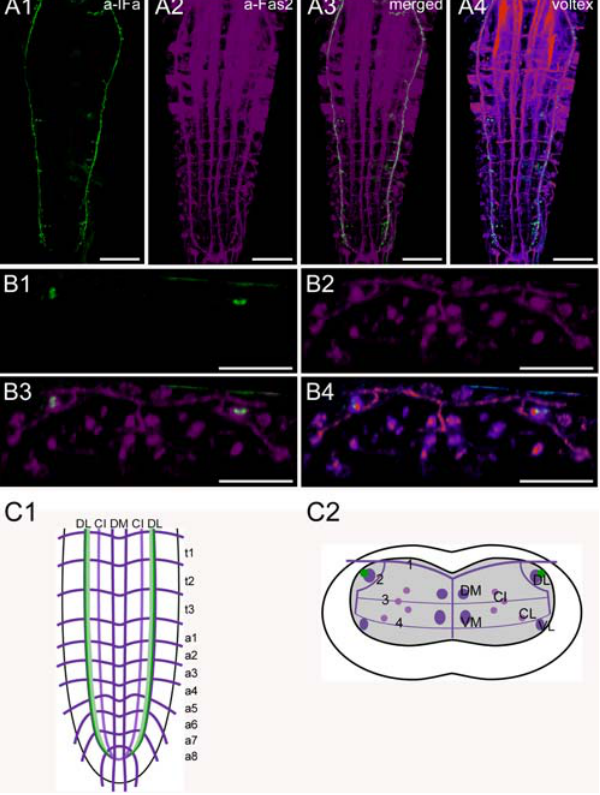
Figure 8. Morphology of IFamide neurons. Mapping of IFa-IR neurons in whole-mount preparations of the thoracic and abdominal neuro- meres of L3 larva in the Fas2 landmark system. A) Dorsal view. B) Transversal view at the height of neuromere a3. C) Idealized dorsal scheme. D) Idealized transverse scheme. Scale bars: 50 m m in A ), 25 m m in B ). Immunostaining is shown in green, Fas2 in